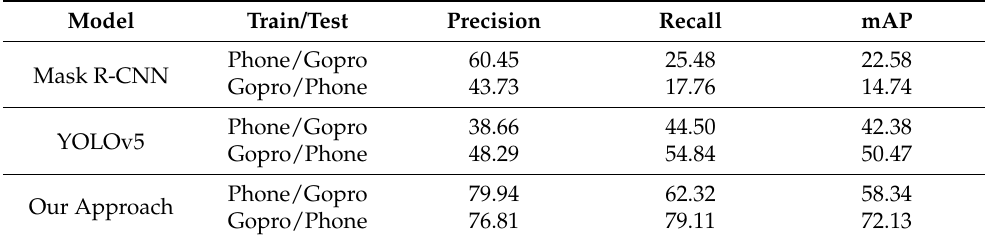
Table 7. Results of training and testing images from different devices.